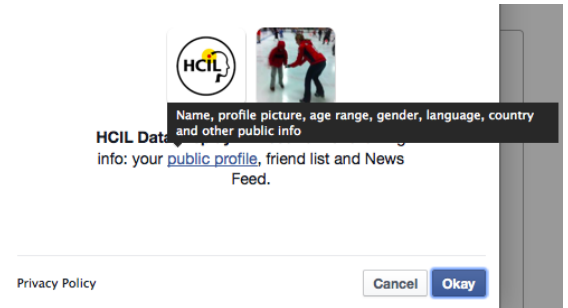
Figure 4. Data access requested by our App Permissions